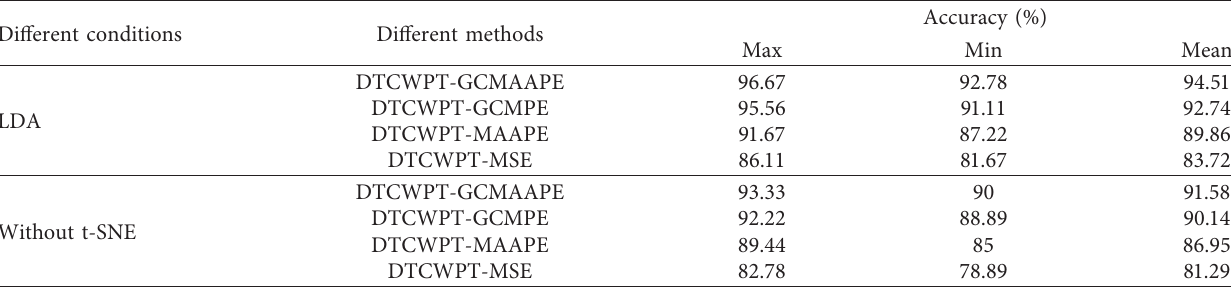
Figure 15: Outputs of GCMAAPE, WT-GCMAAPE, and EEMD-GCMAAPE based fault diagnosis approaches. (a) GCMAAPE. (b) WT- GCMAAPE. (c) EEMD-GCMAAPE. Table 3: The recognition rate of four methods under different